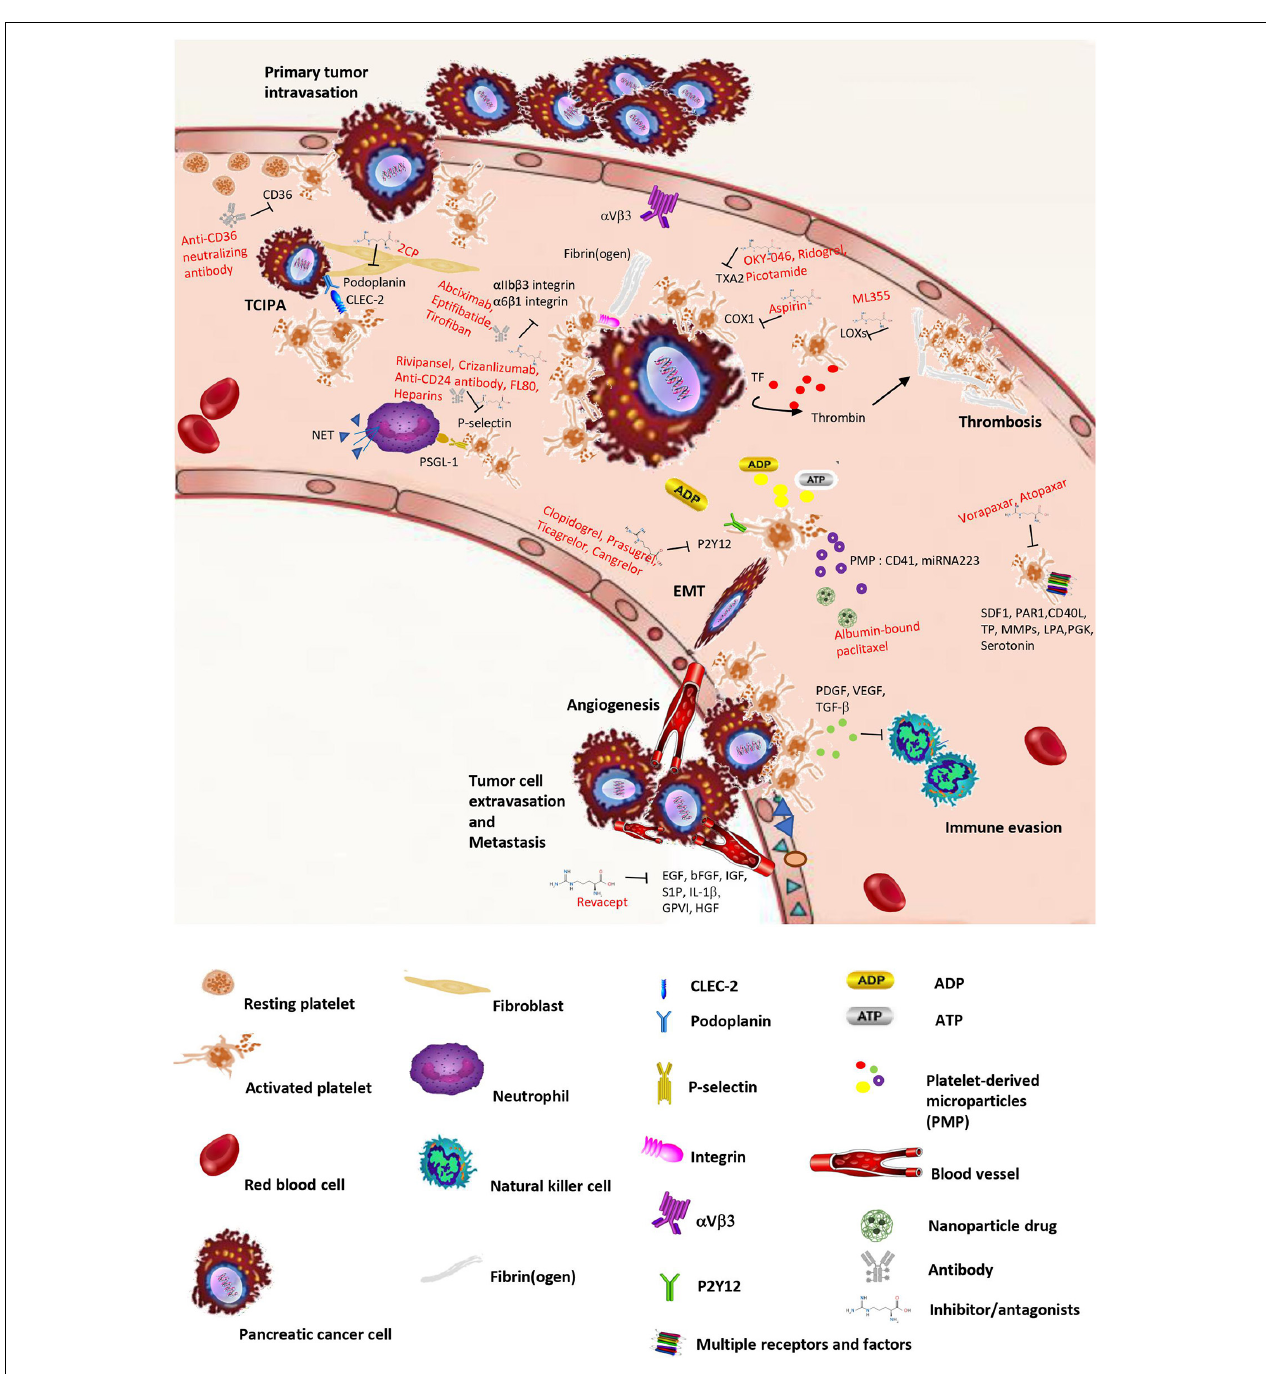
FIGURE 1 | Schematic overview of crosstalk between platelets and pancreatic cancer. Pancreatic cancer can stimulate platelet activation and aggregation (TCIPA), change platelet shapes, and increase platelets’ release of microparticles with loading factors. However, platelet activation releases different kinds of factors, small molecules, and microparticles, which facilitate tumor growth, invasion, and metastasis. In the bloodstream, the tumor cell is surrounded by platelets that protect the encircled tumor cell from immune attack. In addition, platelets increase the properties of cancer cell adhesion and extravasation, thereby supporting cancer cell transmigration and metastasis. The intervention or inhibition of potential drugs in crosstalk between cancer and platelets are shown in the process.